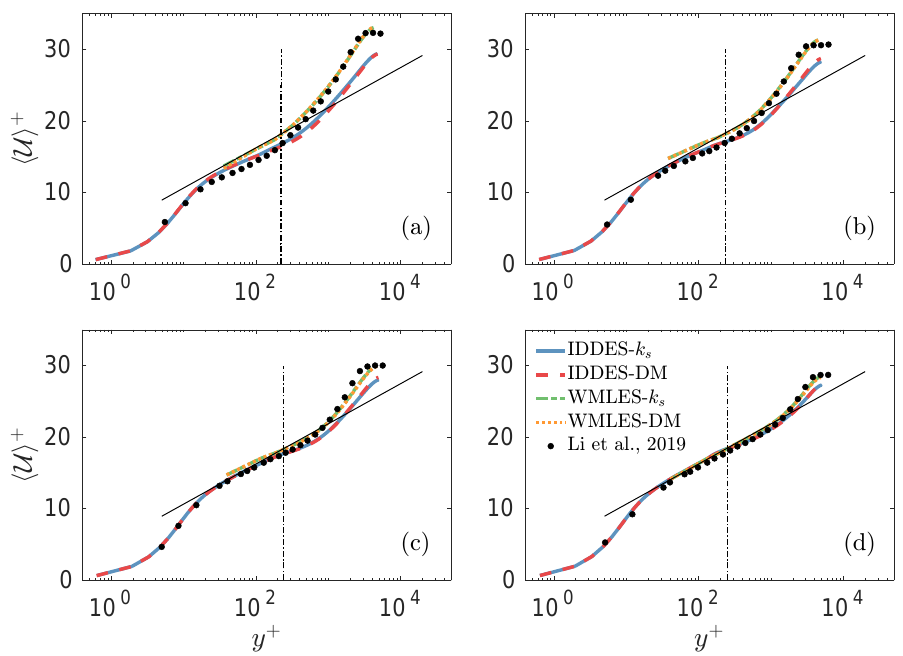
Figure 7. Mean velocity profiles in inner units at ( a ) 3%, ( b ) 10%, ( c ) 19% and ( d ) 63% of the length of the smooth strip. The thin line represents the log law (6), and the vertical dashed line represents the location of the inner/outer layer interface for WMLES